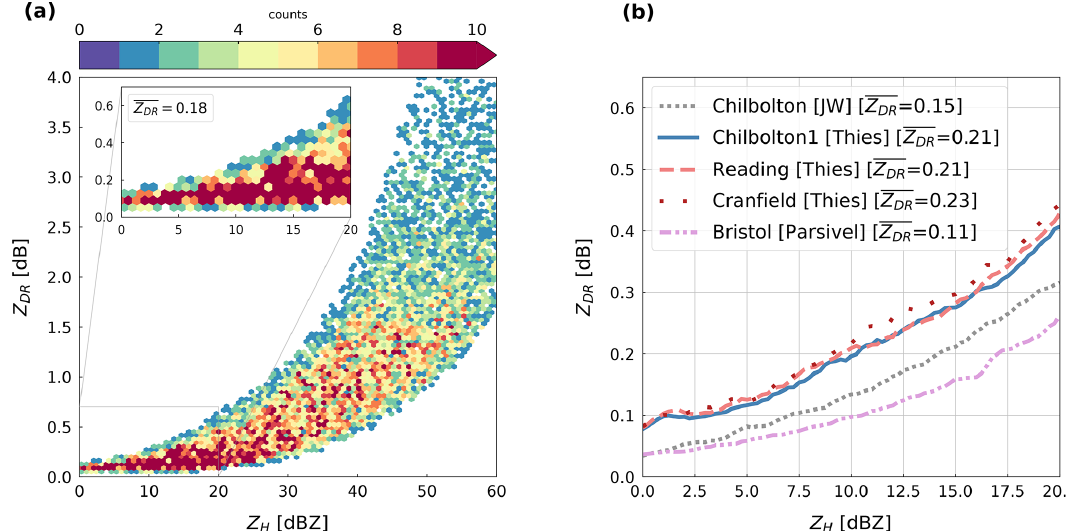
Figure 4. (a) Simulated Z H − Z DR dependencies expected in real storm events; (b) Z H − Z DR dependencies measured by several types of disdrometers at different